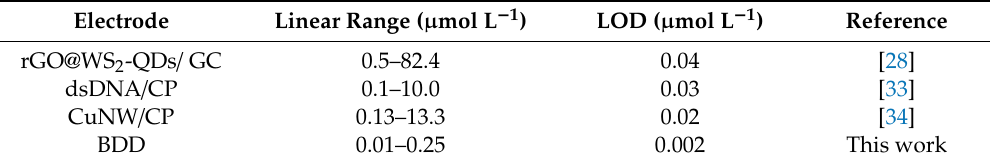
Table 2. Comparison of analytical parameters obtained with the BDD electrode and other modified electrodes from literature for the detection of